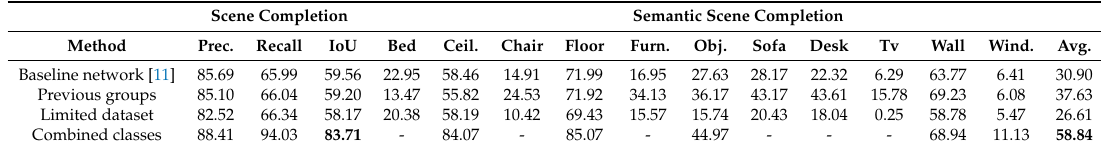
Table 1. Semantic completion results on the SUNCG testset. Baseline network shows reference results using our proposed algorithm as described in the previous section, and should be similar to those using the referred ScanComplete network. Differences between the numbers reported here and in [11] are caused by differences in evaluation metric. Previous groups represents the network trained using previous voxel group predictions. Limited dataset shows the performance drop when using only 1% of the data for training, indicating the potential gain when adding more data. Classes are indicated in the rightmost columns: bed, ceiling (ceil.), chair, floor, furniture (furn.), object (obj.), sofa, desk, tv, wall, window (wind.), and the class average (avg.). Combined classes illustrates the performance increase when combining multiple classes under a single label.